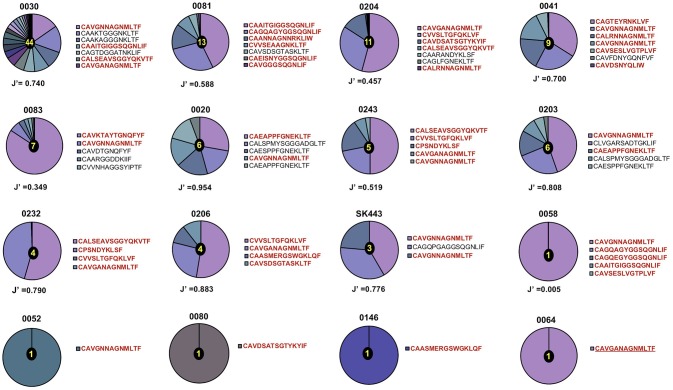
Distribution of TCR-α chain clonotypes in HLA-B*44:03/NW8-specific CD8+ T cells. The frequency of TCR-α chain amino acid sequences obtained from (n = 16) CMV-infected individuals is shown as pie charts. Frequencies of individual clonotypes are calculated as a percentage of aligned sequencing reads. Amino acid sequences of CDR3 loops are shown on the right of each pie, with public CDR3 clonotypes in bold red. Patient IDs are shown above each pie chart. Shannon's evenness index (J′) is indicated under each pie chart. The number in the centre of each pie indicates the total number of clonotypes seen in the corresponding patient. Colours are assigned randomly and do not correspond to a fixed a sequence.